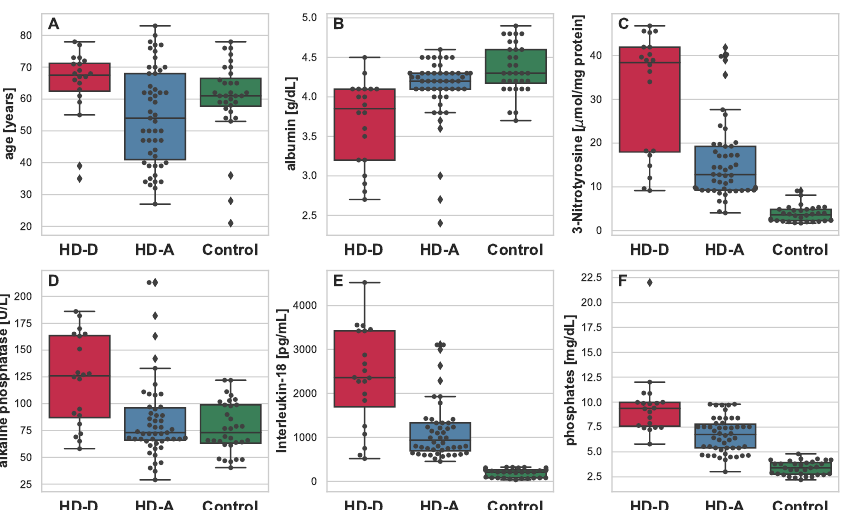
Figure 2. Boxplot depicting differences between HD-D (red), HD-A (blue), and Control (green) for the chosen variables: age ( A ), albumin ( B ), 3-Nitrotyrosine ( C ), alkaline phosphatase ( D ), Interleukin-18 ( E ), and phosphates ( F ). Additional swarmplot was overlaid onto the original plot in order to mark the obtained measurements for each of the patients (dots). Outlier values are represented by diamons.